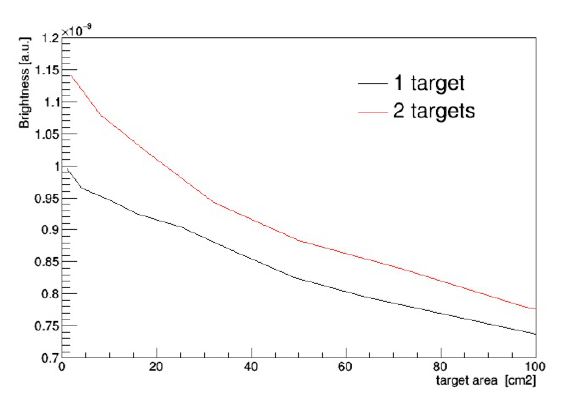
Fig. 9. Target size effect. See explanation in the